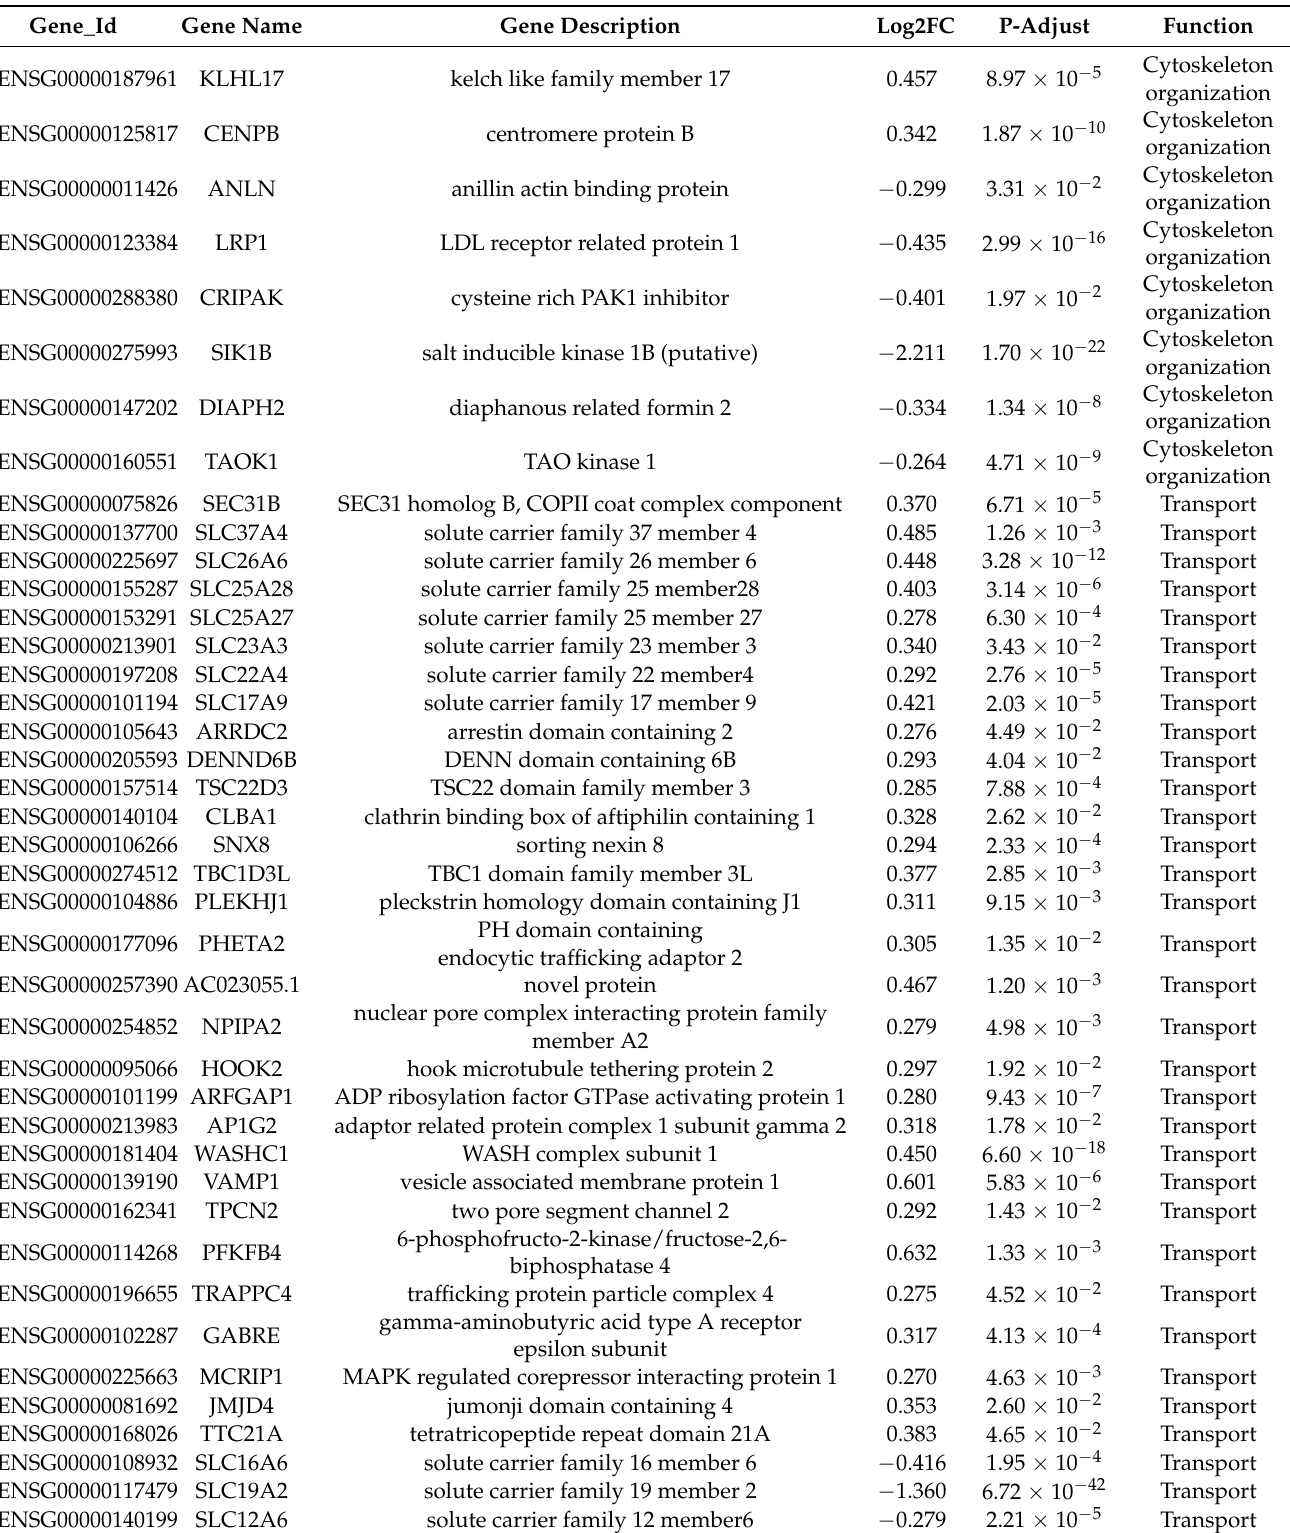
Table 3. Functional characterization of up/downregulated differential expressed genes in UVA- induced